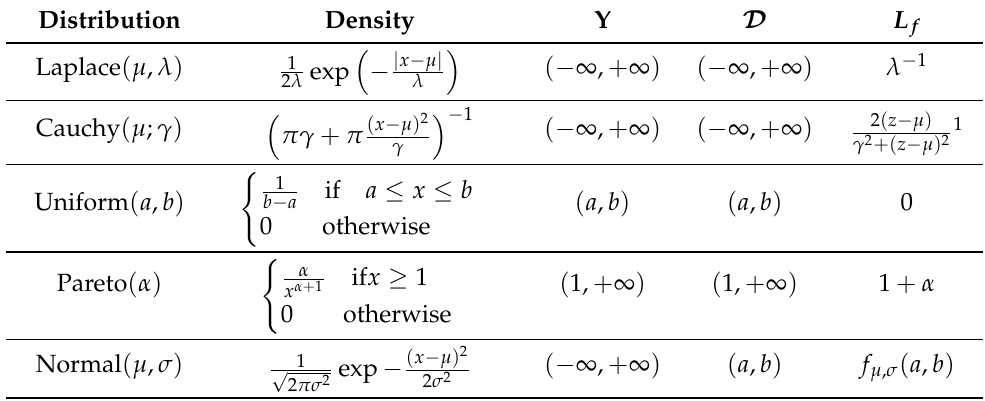
Table 1. Examples of parameters to use for different univariate random